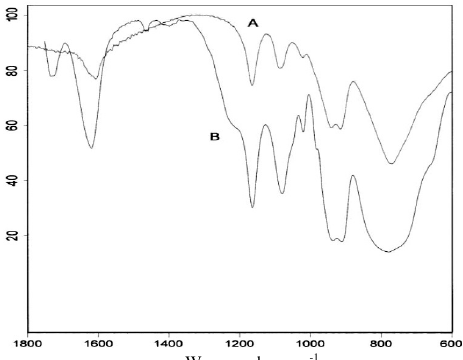
Figure 1. IR spectroscopy of Preyssler heteropolyacid in nano form (A) and bulk form (B)